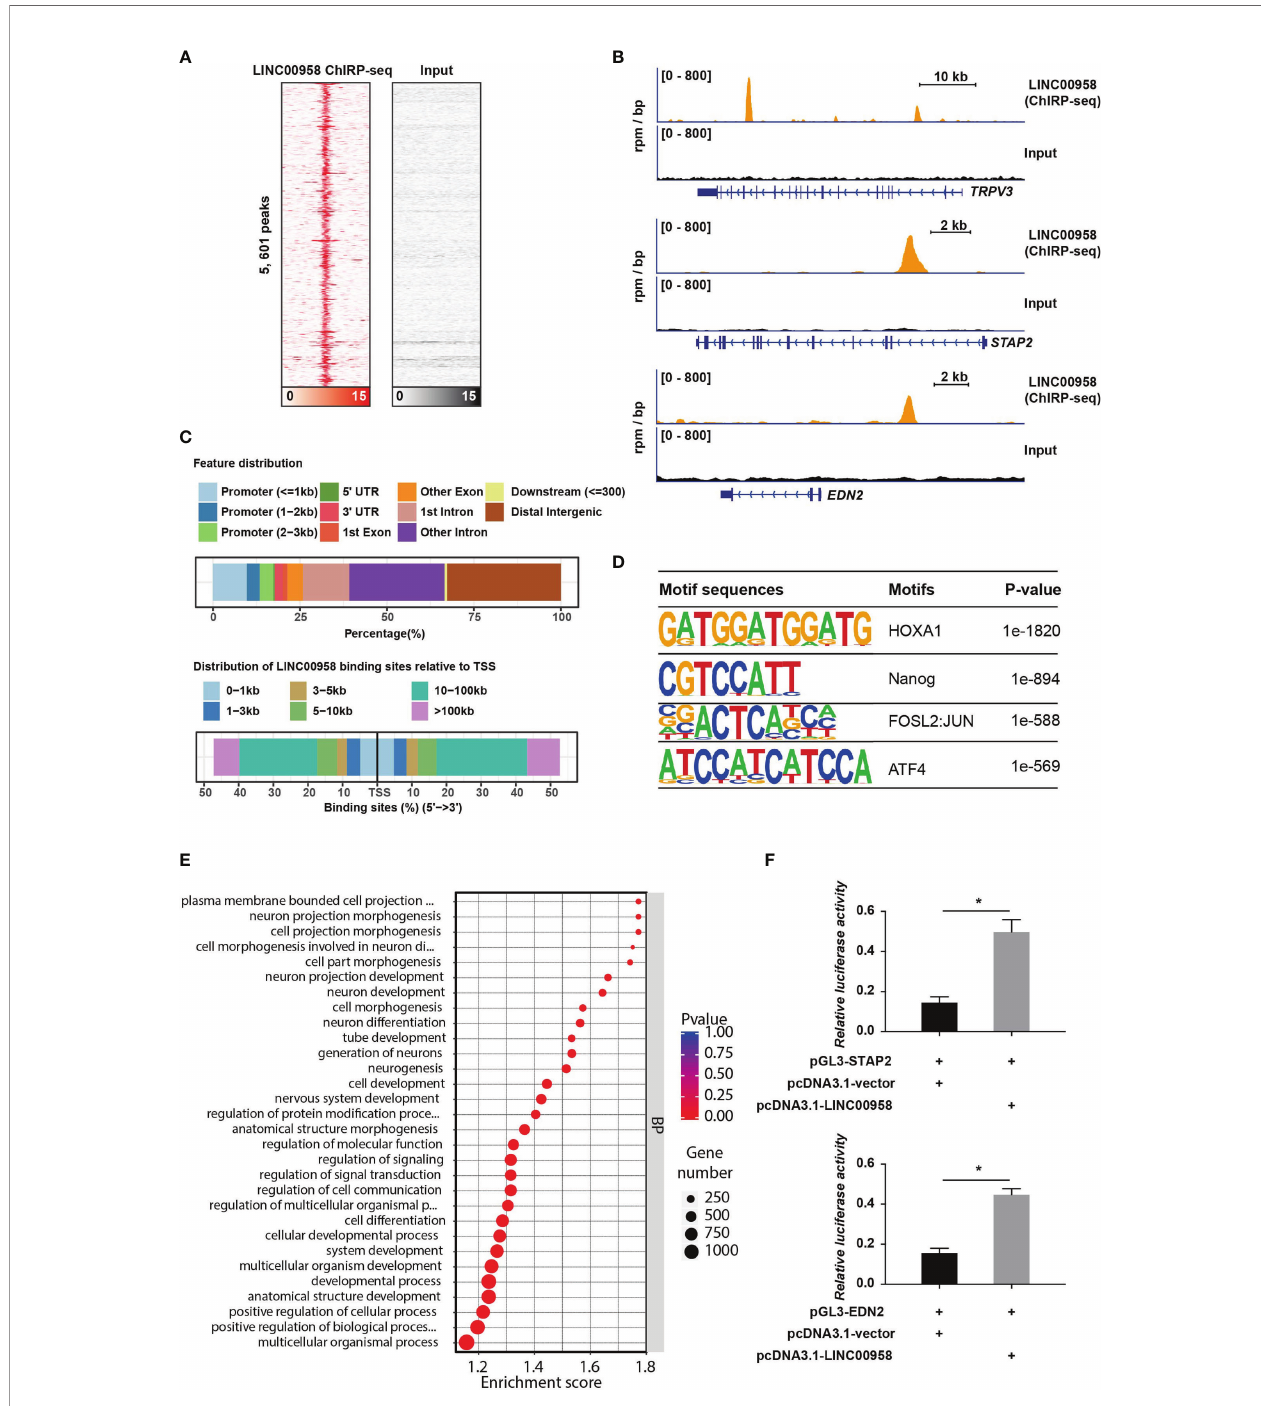
FIGURE 6 | LINC00958 is directly involved in transcriptional regulation. (A) Heatmap showing the binding sites of LINC00958 in the chromatin isolation by RNA puri fi cation assay. The signals near the peak center of the speci fi c LINC00958-bound regions were plotted. (B) Representative illustration of the binding sites of LINC00958 on chromatin. (C) Distribution of LINC00958-bound regions on chromatin. The upper panel shows the features of LINC00958-bound peaks. The lower panel shows the distribution of LINC00958-binding sites relative to the transcription start site. (D) Motif analysis of LINC00958-bound regions was performed using the Homer2 suite. (E) Gene Ontology analysis of LINC00958-bound regions. (F) LINC00958 directly regulated the enhancer activity in A549 cells. A549 cells were subjected to a luciferase reporter assay. The LINC00958-bound regions were cloned into the pGL3-promoter vector. The luciferase constructs were co-transfected with the LINC00958-expressing plasmid or empty vector. * P <